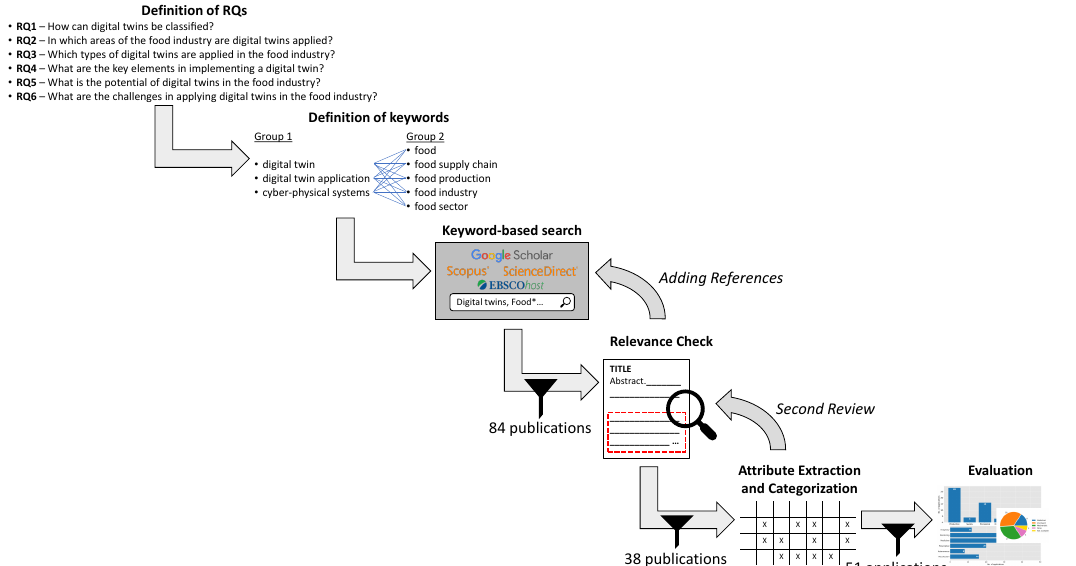
Figure 3. Overview of the methodology for the classification in this survey. Publications found through a keyword-based search were first selected based on the title and abstract. Afterward, the publications were analyzed and relevant publications were categorized in a previously defined